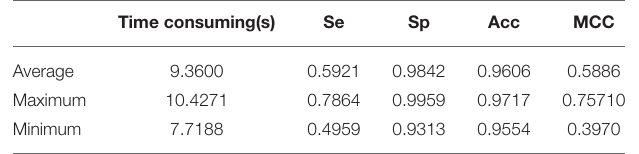
TABLE 3 | Performance of proposed method (DRIVE).